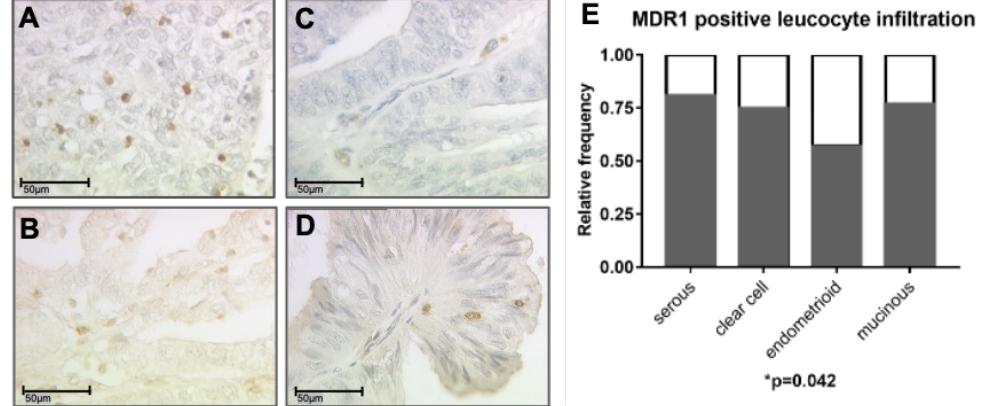
Figure 2. A MDR1 + leucocyte infiltrate was detected by immunohistochemistry in all subtypes: serous ( A ), clear cell ( B ), endometrioid ( C ) and mucinous carcinoma ( D ). ( A – D ) are shown in 40 ×